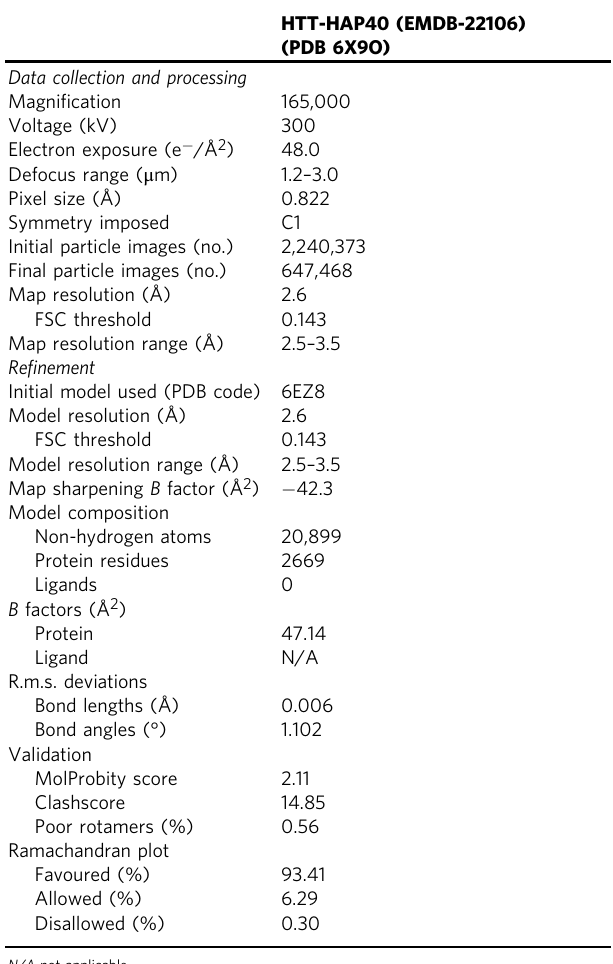
Table 1 Cryo-EM data collection, re fi nement and